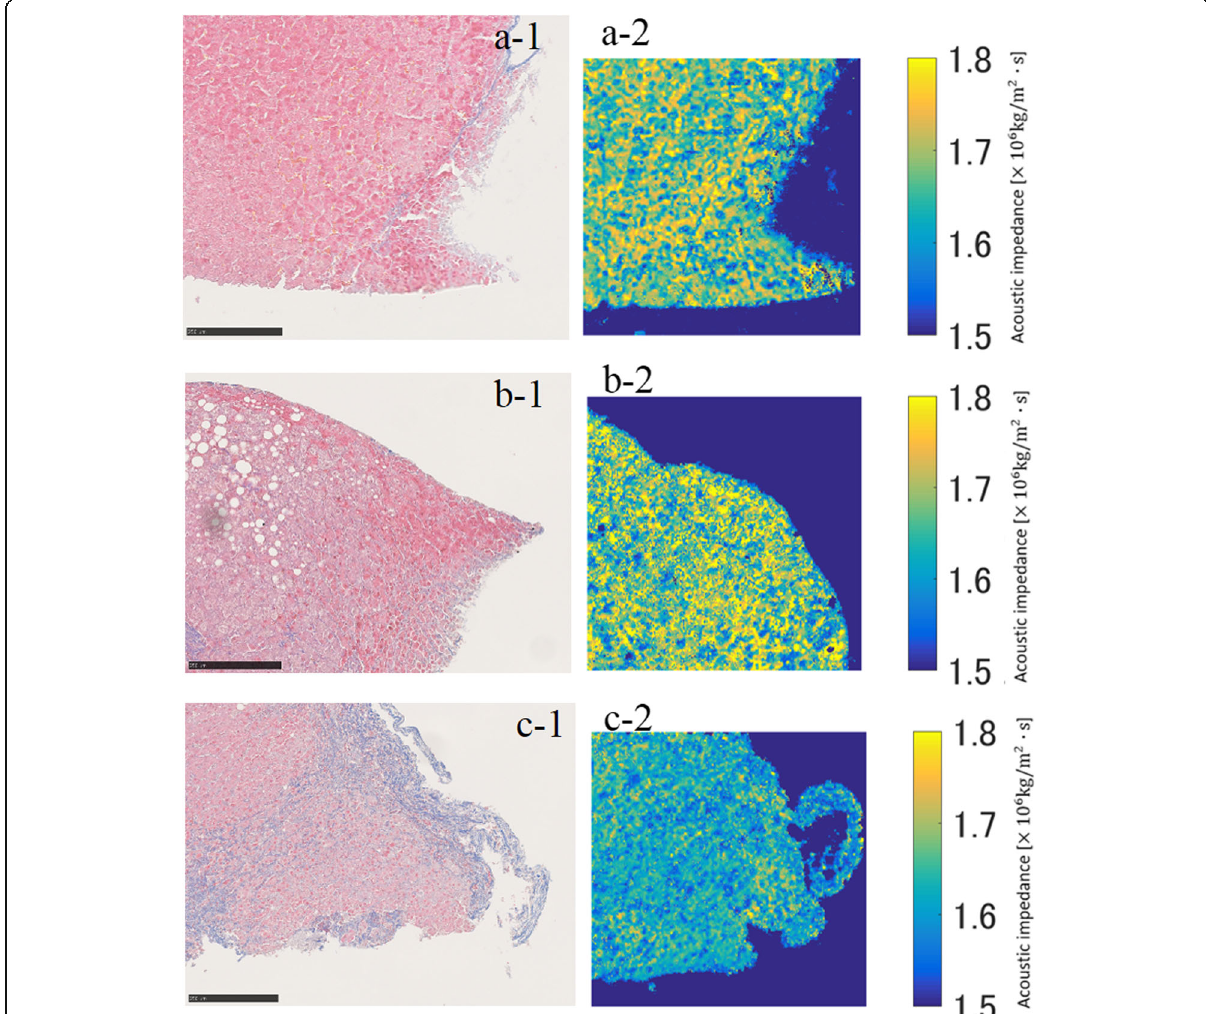
Fig. 1 Images of mouse liver sample. a Control. ( a-1 ) Masson trichrome stain of a control: no fibrosis and no steatosis; ( a-2 ) acoustic impedance image: there is a nearly even distribution of yellow area and blue/green area; median acoustic impedance 1.74 × 10 6 kg/m 2 /s. b Simple steatosis. ( b-1 ) Masson trichrome stain: no fibrosis with 40% fat deposition; ( b-2 ) acoustic impedance image: the blue/green area is larger than the yellow area; median acoustic impedance 1.66 × 10 6 kg/m 2 /s. c Nonalcoholic steatohepatitis. ( c-1 ) Masson trichrome stain: advanced fibrosis (F3 or F4) with 30% fat deposition; ( c-2 ) acoustic impedance image: the blue/green area is dominant; median acoustic impedance 1.6 × 10 6 kg/m 2